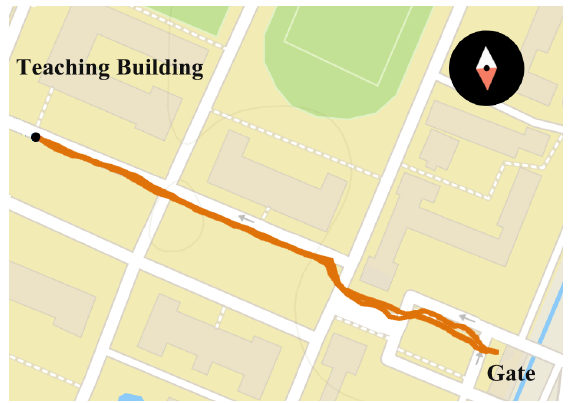
Figure 23. The trajectory of experiments carried out by a volunteer, traveling from a teaching building to the gate of the Yuquan Campus of Zhejiang University. When the camera captured color images, the GNSS module also recorded the longitude and latitude coordinates.